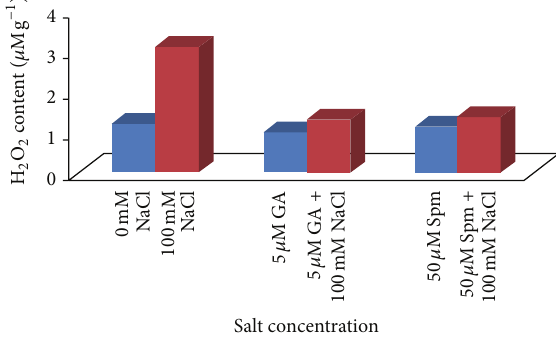
Figure 9: Effect of NaCl on the catalase activity of 10-day-old mungbean seedling and its possible amelioration with 5 𝜇 M GA 3 and 50 𝜇 M Spm.